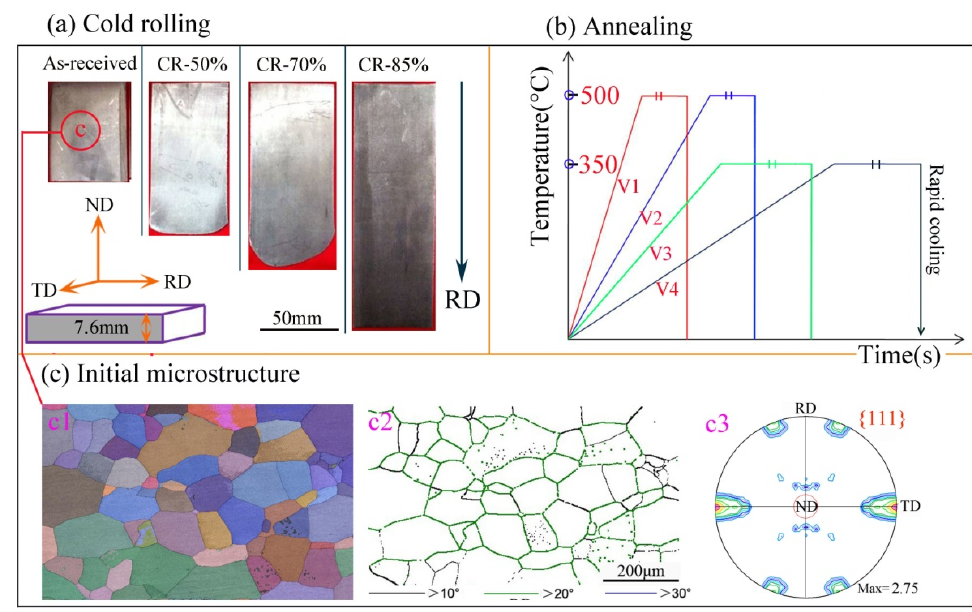
Figure 1. Study process and sample observation of ( a ) cold rolling; ( b ) annealing; ( c ) initial micro- structure of hot-rolled aluminum plate.